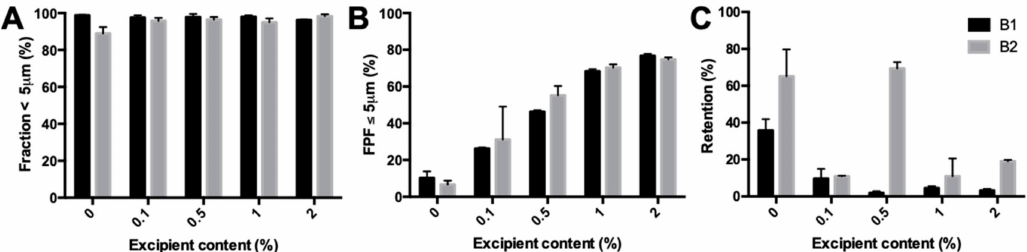
Figure 5. Primary particle size distribution and dispersion data of milled isoniazid with di ff erent fractions of magnesium stearate. ( A ) shows the fraction < 5 µ m found with the RODOS. ( B ) shows the fine particle fraction (FPF) found in the dispersion measurement with a dose of 25 mg and a pressure of 4 KPa. ( C ) is the retention found during those measurements.